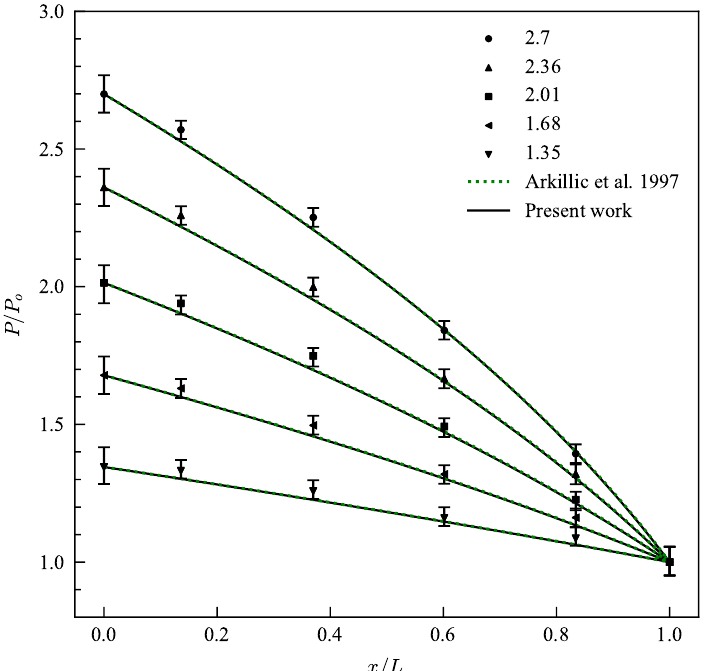
Figure 3. (Color Online) Pressure profiles along the micro-channel for various inlet-outlet pres- sure ratios as predicted by the current model (solid-line) plotted against the experimental data by Pong et al. [41] and pressure profiles predicted by analytical solution of Arkilic et al.